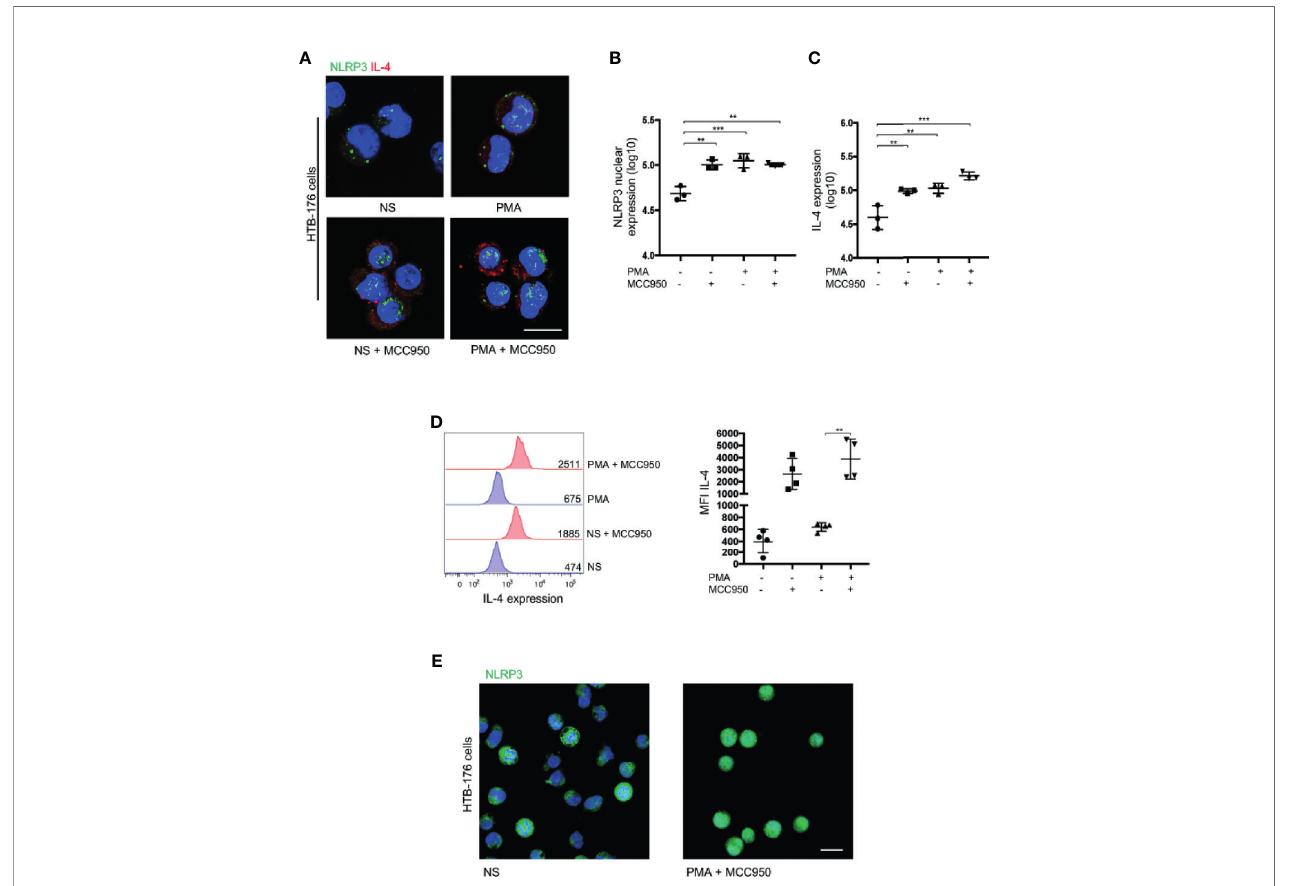
FIGURE 4 | Nuclear localization of NLRP3 positively regulates IL-4 in malignant CD4 + T cells from CTCL patients. (A) HTB-176 cells were stimulated with PMA/ ionomycin with or without an NLRP3 assembly inhibitor (MCC950). Representative immuno fl uorescence (IF) for NLRP3 (AF-488) and IL-4 (AF-594) expression. Quanti fi cation of (B) NLRP3 nuclear expression and (C) total expression of IL-4 in the microphotographs of the different treatments (n = 4). (D) Flow cytometric analysis of cells treated as in (A) , representative histogram and MFI plot of IL-4 expression (n = 3). (E) Z-stack imaging and reconstruction depicting NLRP3 expression in HTB-176 cells not stimulated or after treatment with PMA plus the NLRP3 assembly inhibitor ( Supplementary Videos 3 and 4 , respectively). Error bars = SEM; **P < 0.01; ***P < 0.001. Scale bars= 20